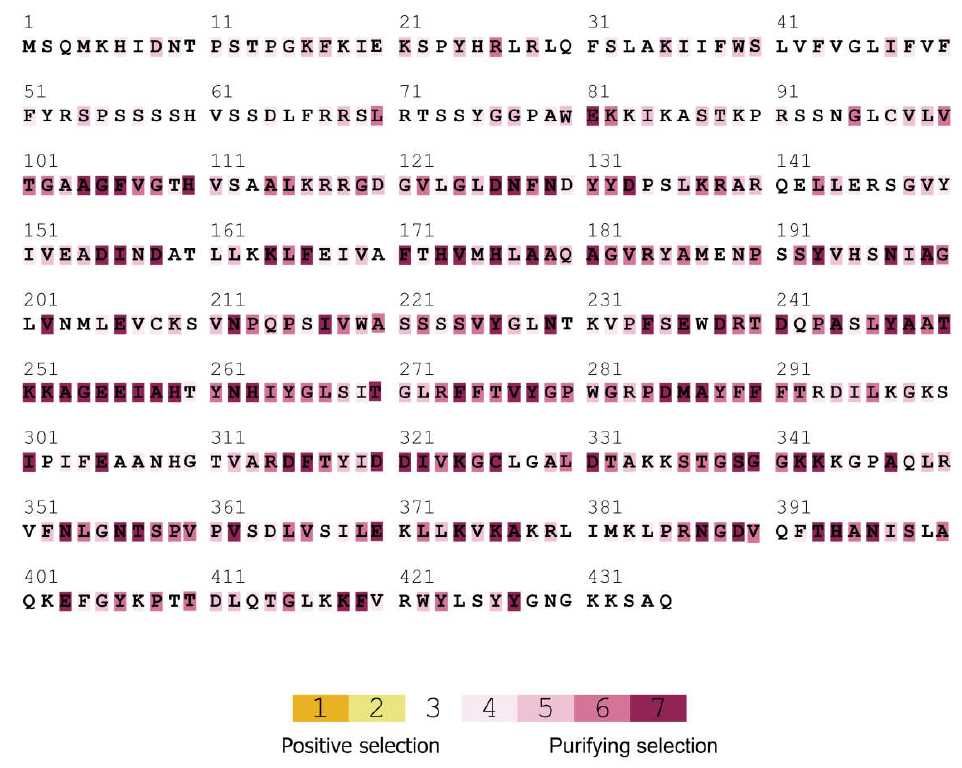
Figure 7. Selection pressure analysis of the UGlcAE proteins in tomato. The red shades represent ω < 1 (purifying selection). Amino acid sequence of SlUGlcAE3‐like1 is shown, and the sequences of other SlUGlcAE proteins are presented in the Supplementary Materials Figure S2.